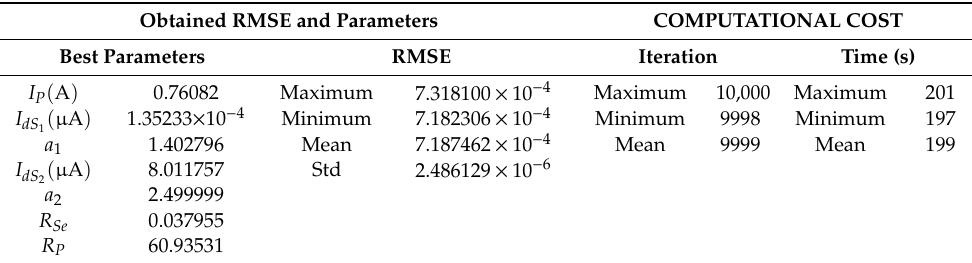
Table 4. Results for the double-diode cell.